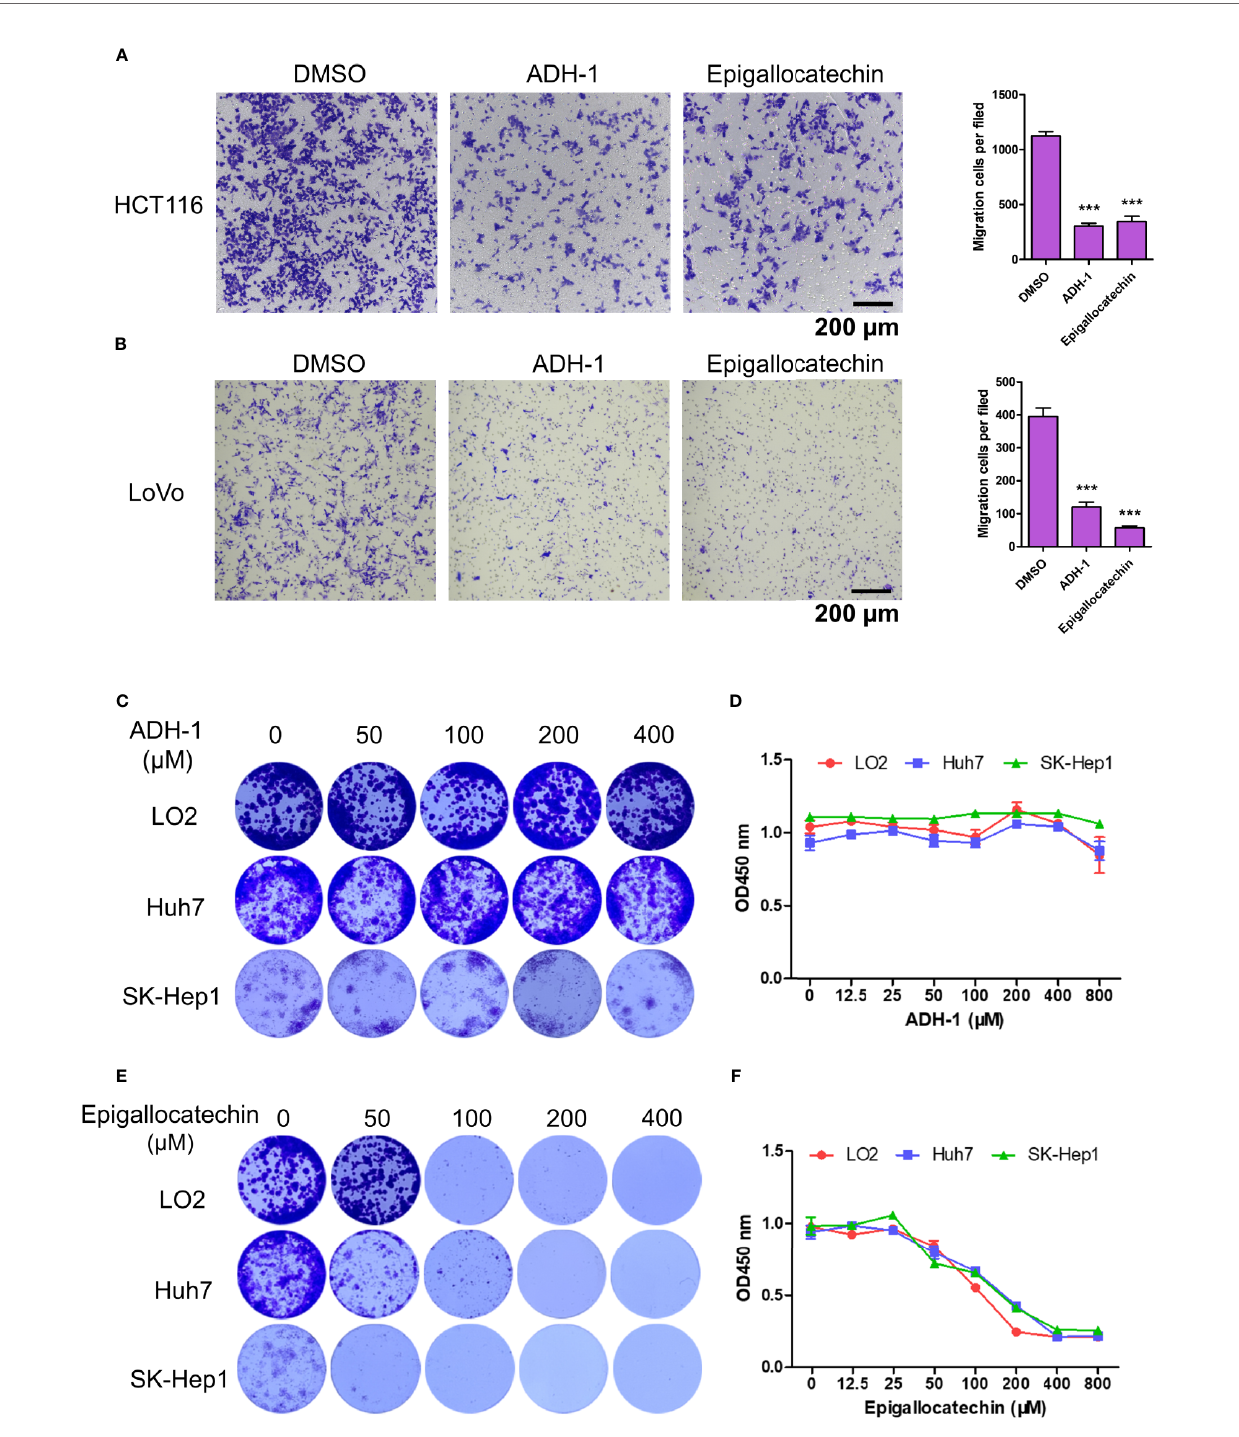
FIGURE 9 | ADH-1 and epigallocatechin suppress colorectal cancer cells metastasis. Transwell assay for (A) HCT116 and (B) LoVo treated with ADH-1 and epigallocatechin at 200 m M, 24 h. Left panel: crystal violet staining. Scale bar = 200 m m. Right panel: statistic results of migration cells per fi led (n = 6). *** p < 0.0001. Colony formation assay for LO2, Huh7, and Sk-Hep1 treated with (C) ADH-1 and (E) epigallocatechin for 10 days at different concentrations. CCK8 kit measured cell viabilities of LO2, Huh7, and SK-Hep1 treated with (D) ADH-1 and (F) epigallocatechin for 3 days at different concentrations (n = 6). Statistics shown as mean ±